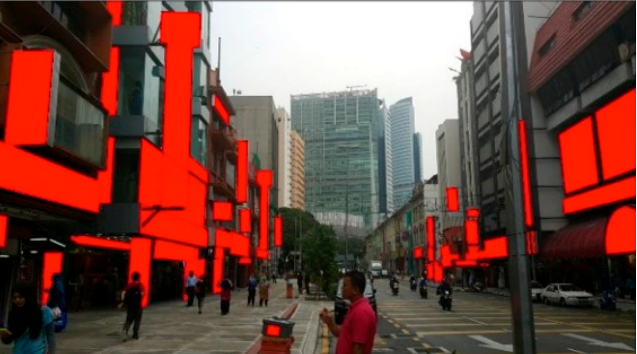
Figure 8. An example of area cumulative analysis for one of the scenes shows a scene in AutoCAD’s digital environment (Code: A) the existing level of advertisement board's exposure (%) = 16.27% of the total pictorial area. Table 1. Existing level of pollution exposure in